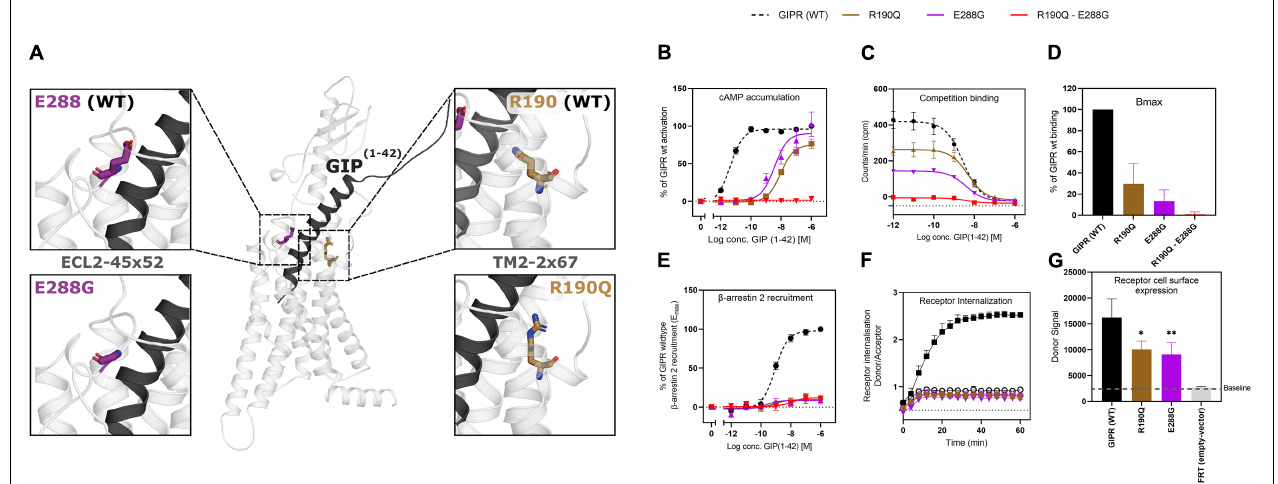
FIGURE 1 | Structural localization of R190Q and E288G on the wild-type GIPR and the molecular pharmacological phenotype of the variants. (A) Structural illustration of the wild-type GIPR and the position of the GIPR variants, R190Q and E288G. (B) Dose-response curve in cAMP accumulation of wild-type GIPR, R190Q, E288G and double mutant. (C) Dose-response curves of the homologous competition binding data with [ 125 I]GIP and unlabeled GIP at 4 ◦ C for 3 h of wildtype GIPR, R190Q, E288G and double mutant. (D) Corresponding B max values. (E) Dose-response curve of β -arrestin 2 recruitment of wild-type GIPR, R190Q, E288G and double mutant. (F) Internalization of SNAP-GIPR, SNAP-R190Q and SNAP-E288G over time following stimulation with 1 µ M GIP vs. baseline. (G) Receptor cell surface expression levels of SNAP-GIPR, SNAP-R190Q, SNAP-E288G, and FRT (empty-SNAP-vector). Data represent the mean ± SEM of minimum n = 3. Independent experiments are performed in either duplicate or triplicates. Statistical significance was assessed using an ordinary one-way ANOVA for receptor cell surface expression (* p < 0.05; ** p < 0.01; as compared to wild-type